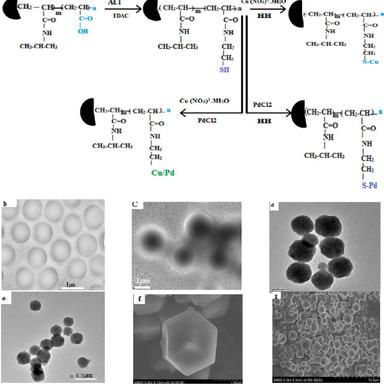
(a): Representation photograph for the preparation of PNIPAM–Cu hybrid microgels via Au–thiol chemistry TEM images (b): Carboxyl-functionalized PNIPAM microgels (c): thiol-functionalized PNIPAM microgels (d): PNIPAM–Cu hybrid microgels.